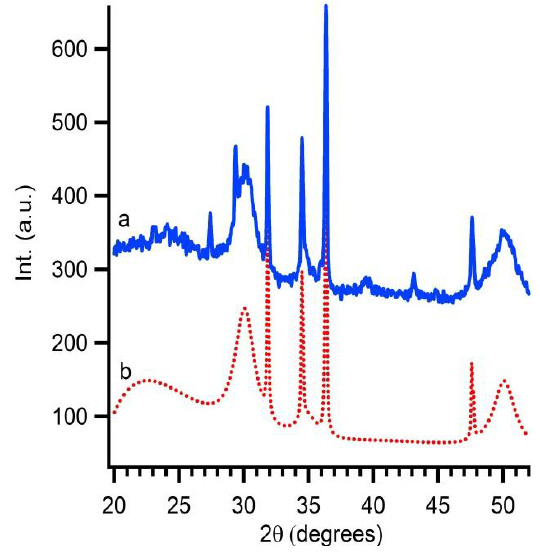
Figure 6. Rietveld refinement of the sample treated at 400 °C for 1 h with ( a ) the experimental data, sample inclusive internal standard; and ( b ) the calculated